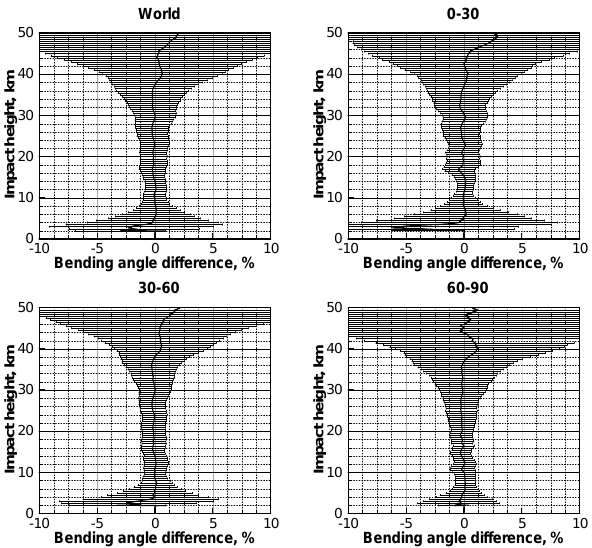
Fig. 5. Statistical comparison of GRAS RS+CL raw bending angles Figure 5. Statistical comparison of GRAS RS+CL raw bending angles for October 2007 with 3 for October 2007 with bending angles obtained by the forward mod- bending angles obtained by the forward modeling from ECMWF analyses: the whole globe 4 eling from ECMWF analyses: the whole globe (“World”), tropics (‘World’), tropics (‘0–30’), mid-latitudes (‘30–60’), and polar latitudes (‘60–90’). 5